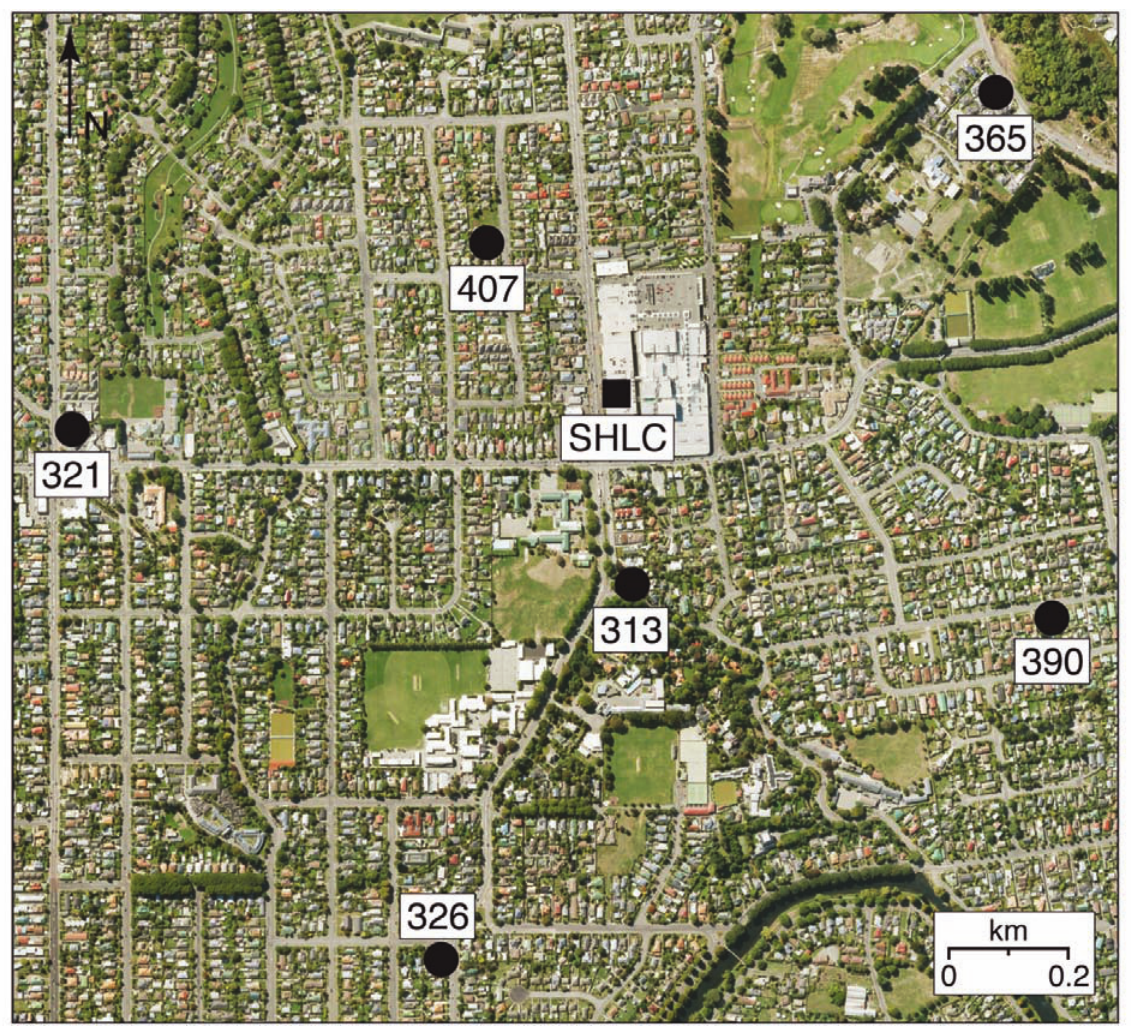
Figure 4. Map of the small-scale array of six QCN stations (circles) installed near the GeoNet station SHLC (square). The location of the map is shown in Figure 1. Additional information about each of the stations is given in Table